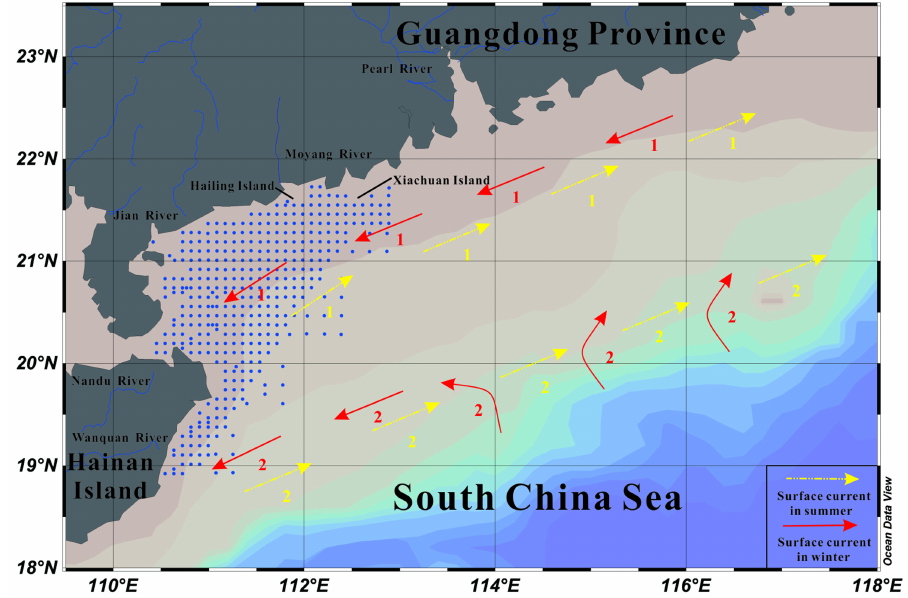
Figure 1. Map of the study area showing the locations of surface sediment samples. Seasonal variations of surface circulation patterns on the northern South China Sea continental shelf (revised from reference [13]). 1. Chinese Coastal Current; 2. South China Sea warm